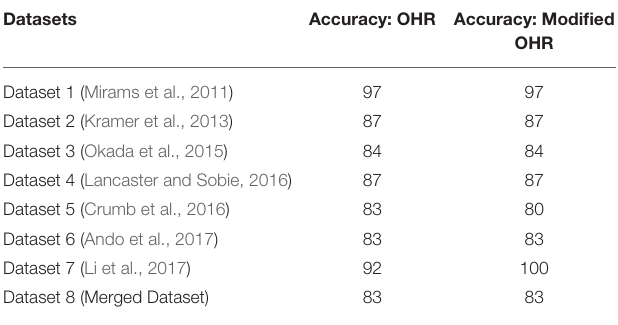
TABLE 3 | Accuracy of drug classification based on EAD.